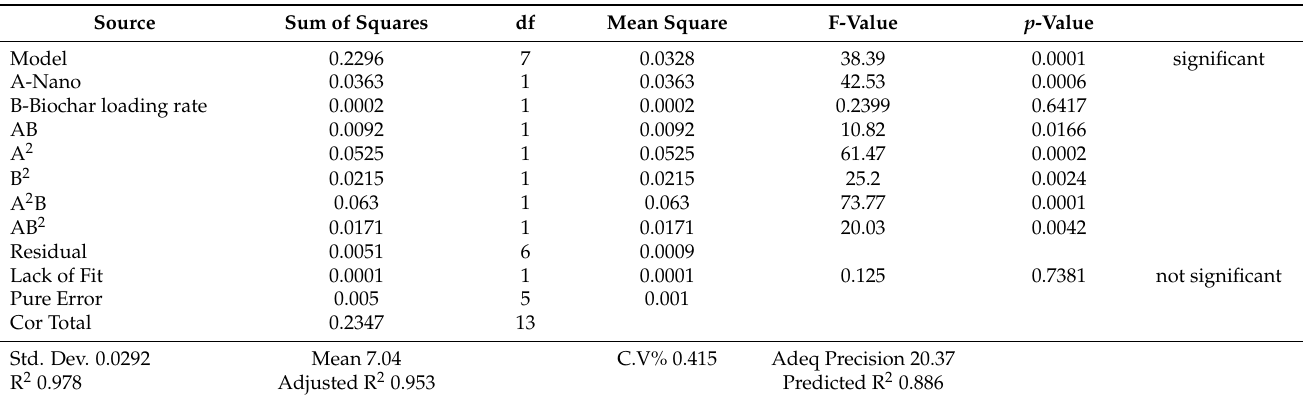
Figure 3. Predicted and experimental results of ( a ) pH, ( b ) biogas production, and ( c ) COD reduction. Table 2. Analysis of variance of pH response.